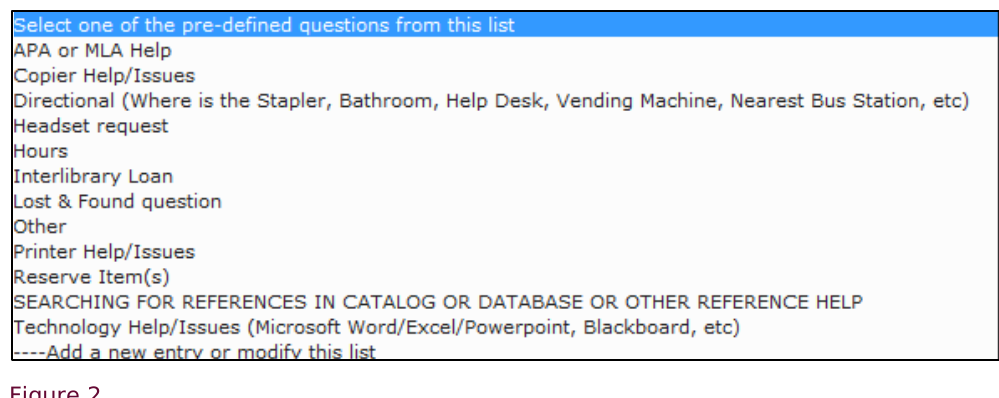
Neumann University Library Reference Analytics form. Staff members click on the down arrow at the top to view a drop-down menu and select a pre-defined question.